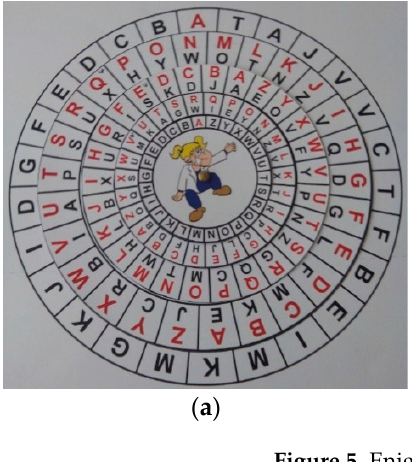
Figure 5. Enigma simulator. ( a ) Wheel enigma simulator of MUDIC. ( b ) Paper enigma machine for crisp tube.